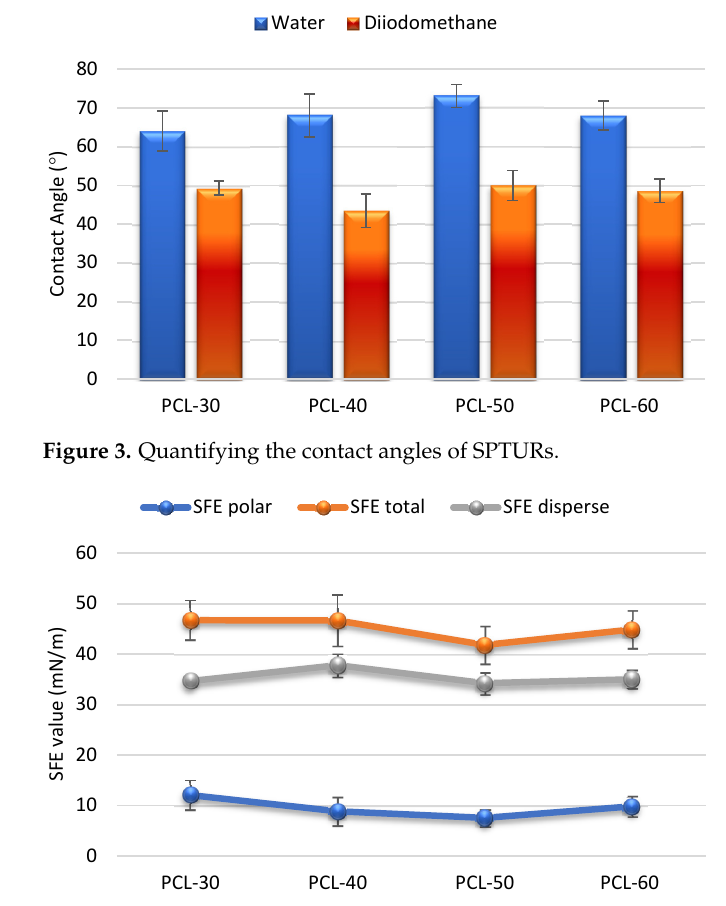
Figure 4. SFE values of synthesized polymers.